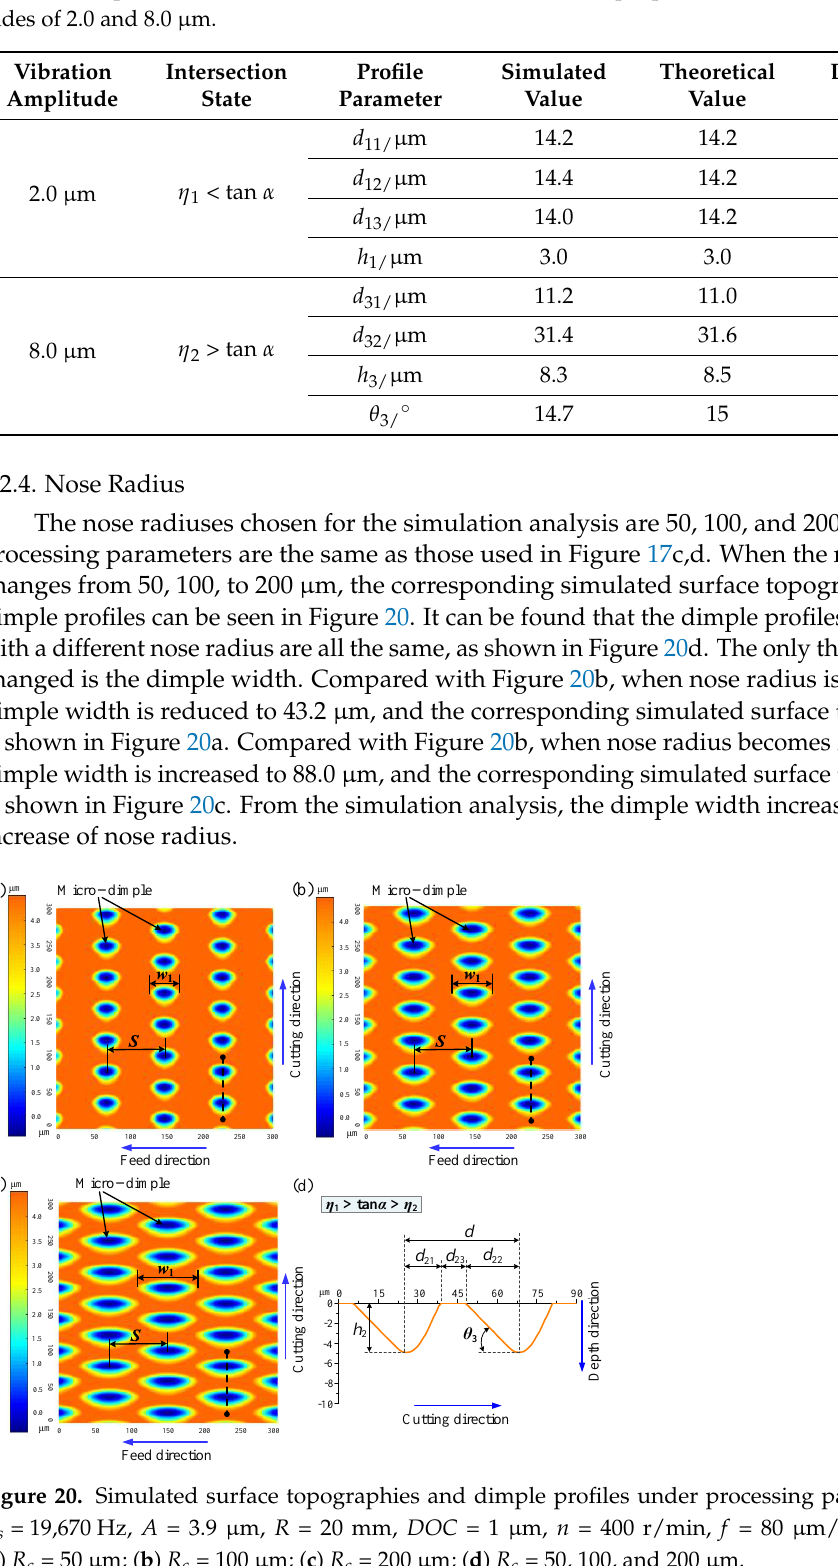
Micro dimple Micro dimple Figure 21. Simulated surface topographies and dimple profile under processing parameters of f us = 19,670 Hz, A = 3. 9 μ m, R = 20 mm, DOC = 1 μ m, n = 400 r/min, α = 15°, R c = 10 0 μ m. ( a ) f = 4 0 μ m/rev; ( b ) f = 8 0 μ m/rev; ( c ) f = 12 0 μ m/rev; ( d ) f = 40, 80, and 12 0 μ m/rev.